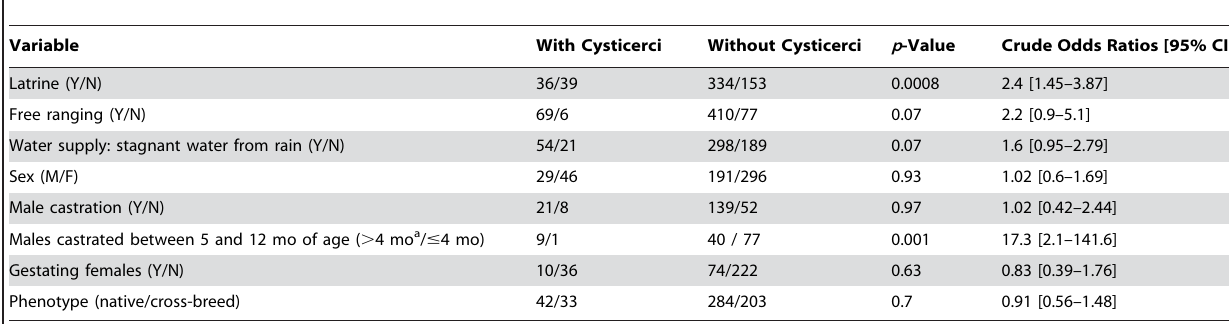
Table 3. Risk factors related to cysticercosis in the 13 rural villages of the Sierra de Huautla, Morelos.